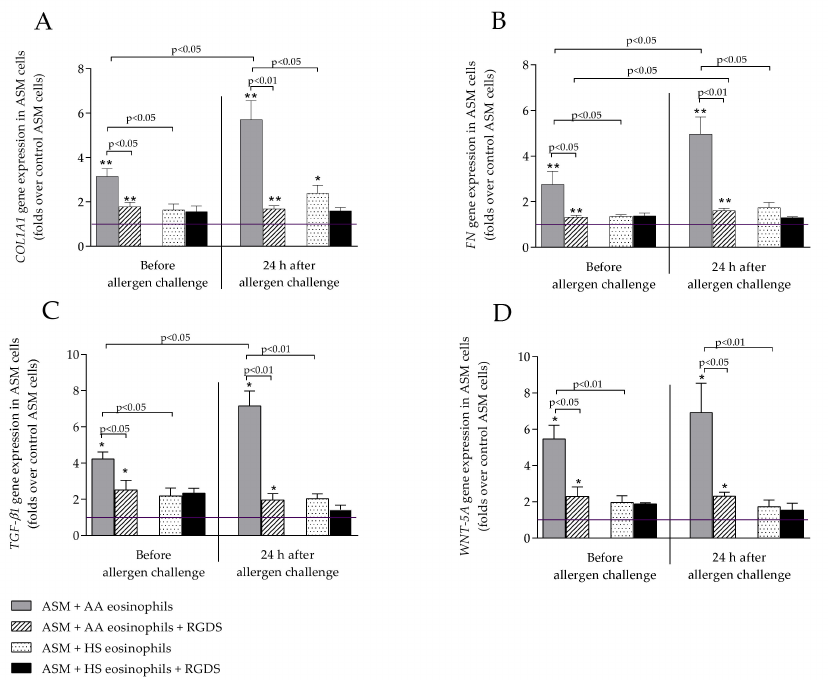
Figure 2. COL1A1 ( A ), FN ( B ), TGF- β 1 ( C ), and WNT-5A ( D ) expression in ASM cells after combined culture with eosinophils before and 24 h after allergen challenge. Data represented as mean ± SEM evaluatedasfoldsovercontrolASMcellsthatwerenotincubatedwitheosinophils. AA—allergicasthma; ASM—airway smooth muscle cells; COL1A1 —collagen I A 1 gene; FN —fibronectin gene; HS—healthy subject; RGDS—arginyl-glycyl-aspartyl-serine peptide (Arg-Gly-Asp-Ser); TGF- β 1 —transforming growthfactor β 1gene; WNT-5A —wingless / integrase-1-5Agene. * p < 0.05comparedtocontrolASMcells; ** p < 0.01 compared to control ASM cells; AA n = 12, HS n = 11. Statistical analysis—Mann–Whitney U test for analysis between AA and HS; Wilcoxon matched-pairs signed-rank test for analysis between the dependent groups; Wilcoxon signed-rank test for analysis against control ASM cells. Lines connect comparison groups with p -value denoting the significant di ff erence in pair-wise